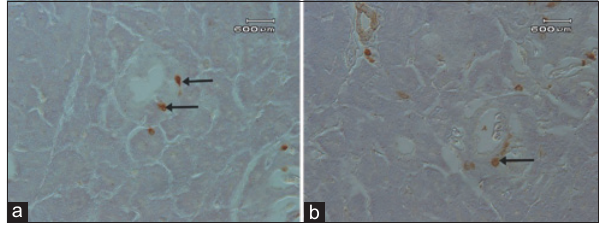
b Figure-3: The glucagon and somatostatin cells in the pancreatic ducts of the Sunda porcupine. In the pancreatic duct, fusiform shaped glucagon cells were detected in the inter-epithelial cells of epithelial duct (a) and round shaped somatostatin cells were detected in the subepithelial cells of epithelial duct (b) as indicated by arrows.